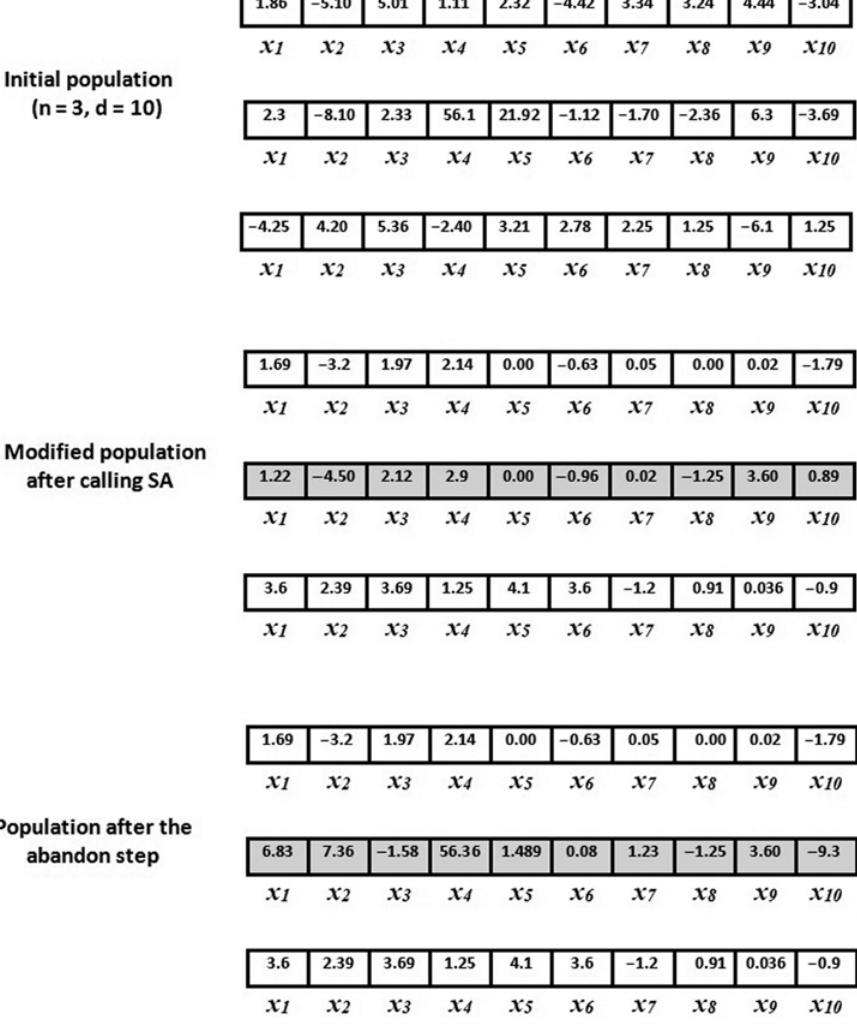
Figure 6: Numerical Example of